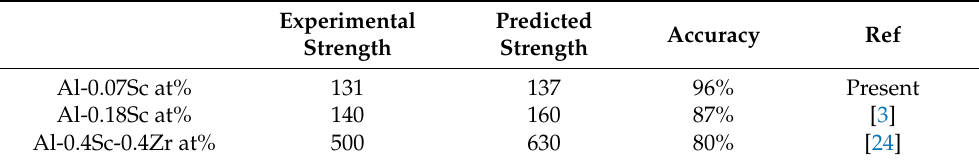
Table 5. Accuracy of strengthening predictions using/not using Bayesian optimization.